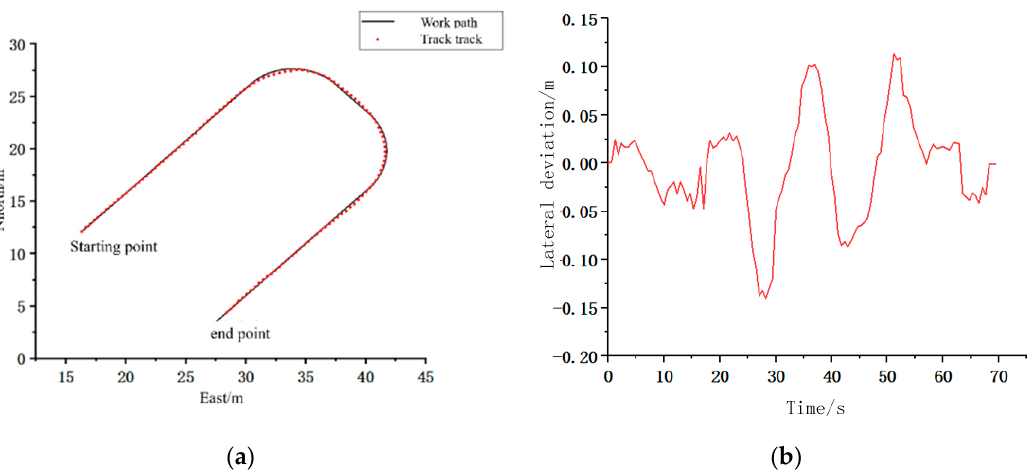
Figure 20. Bow turn route tracking track ( a ) Bow-turn section path tracking; ( b ) Lateral deviation.